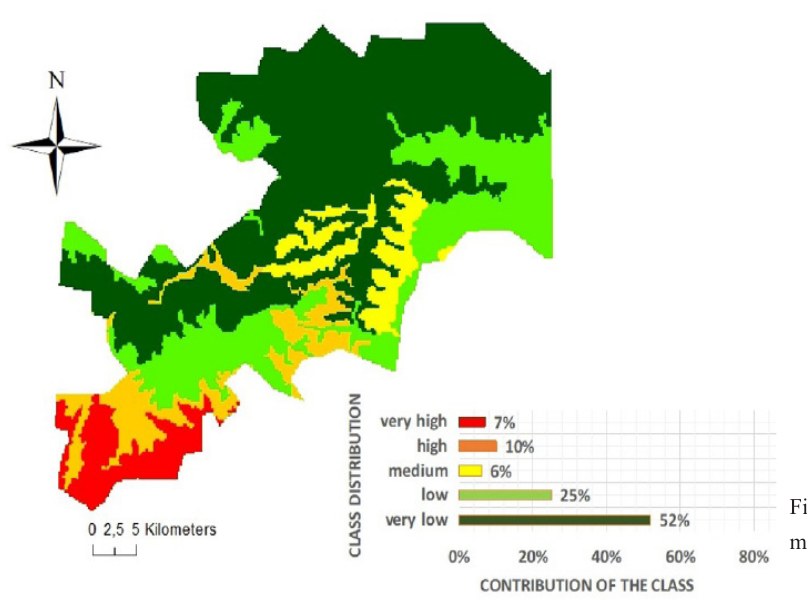
Figure 4. Komati Gorge soil factor